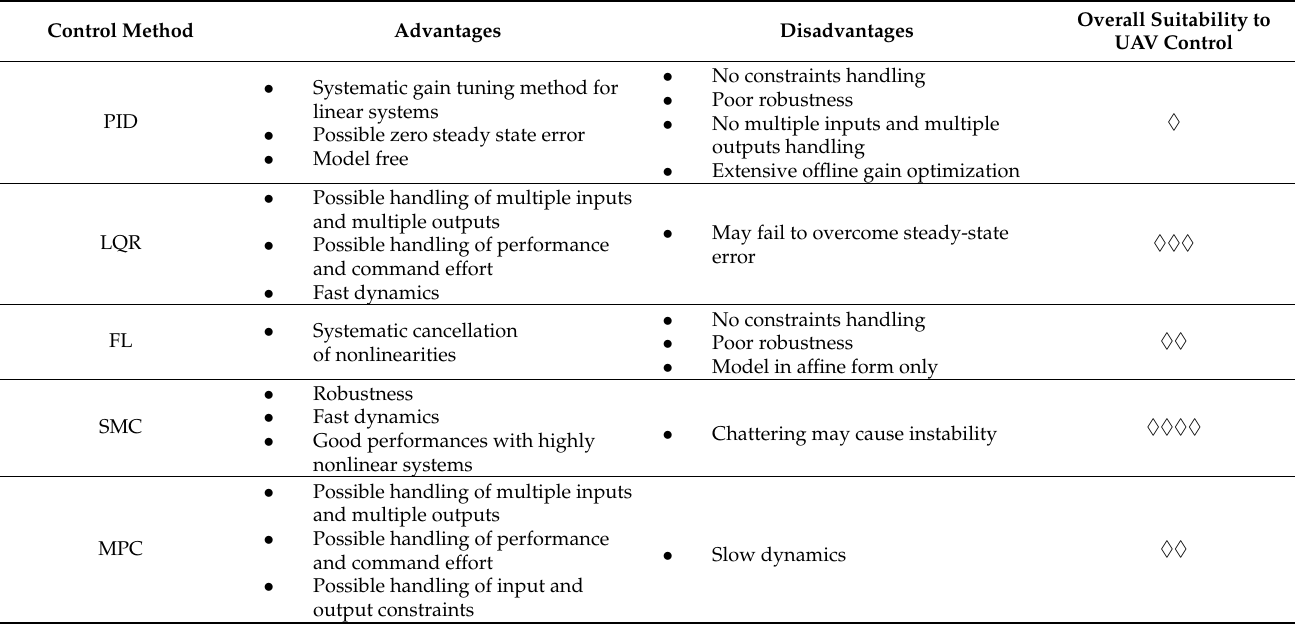
Table 4. Summarizing table of considerations drawn from the study. The number of diamonds is proportional to the “suitability of the method to UAV